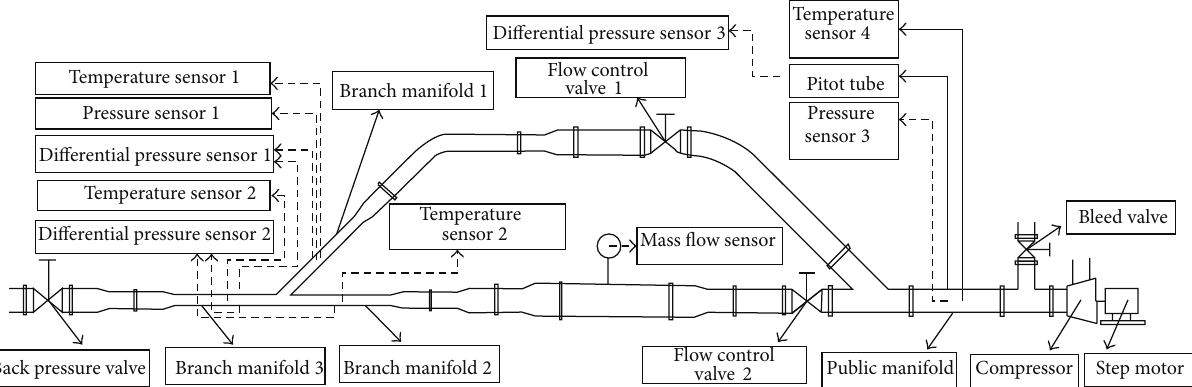
Figure 1: Schematic diagram of the experiment.